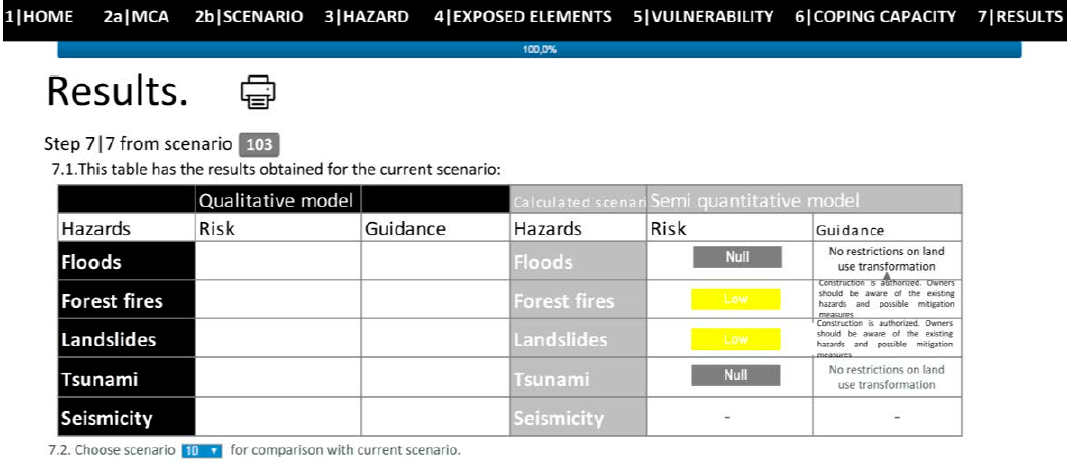
Figure 9. Results for the semi-quantitative risk analysis base scenario.